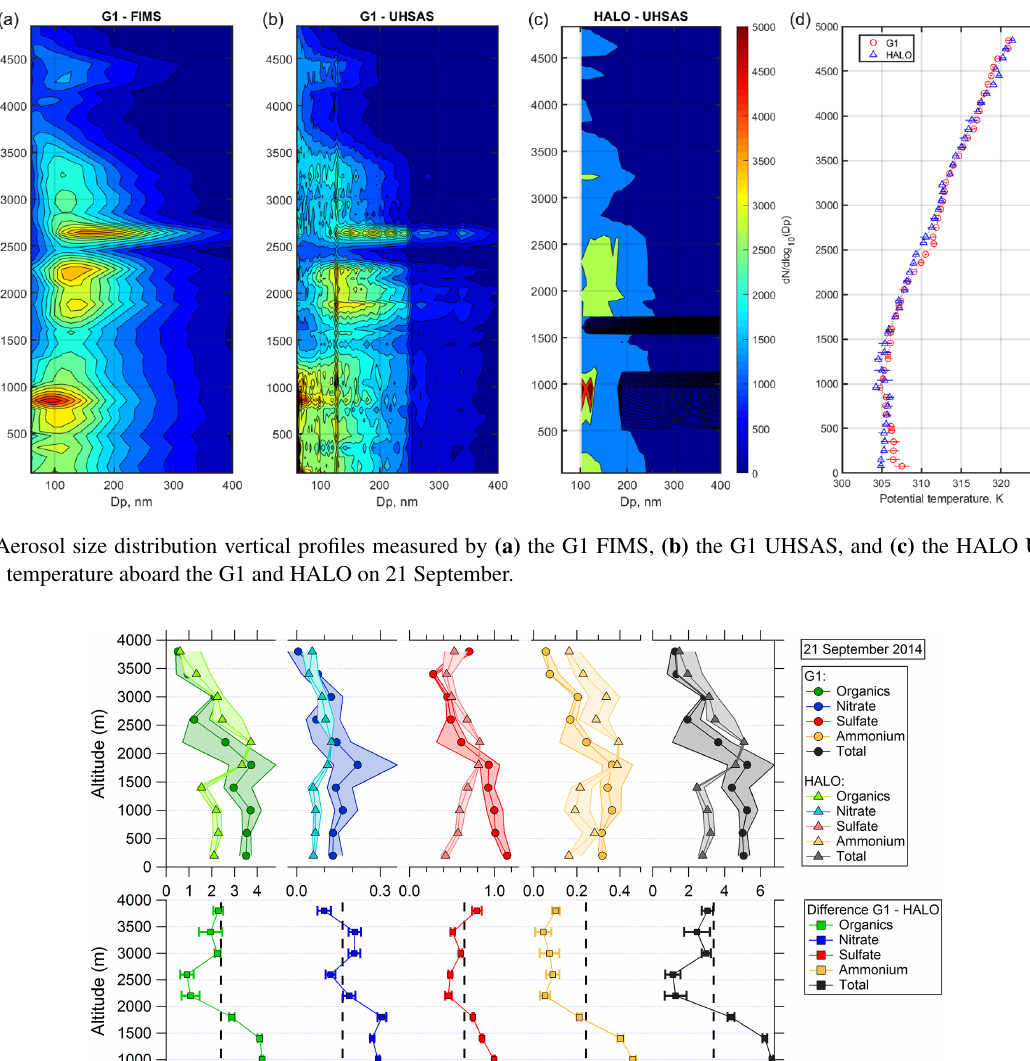
0 . 19 ± 0 . 07 and 0 . 19 ± 0 . 08, respectively. Those values